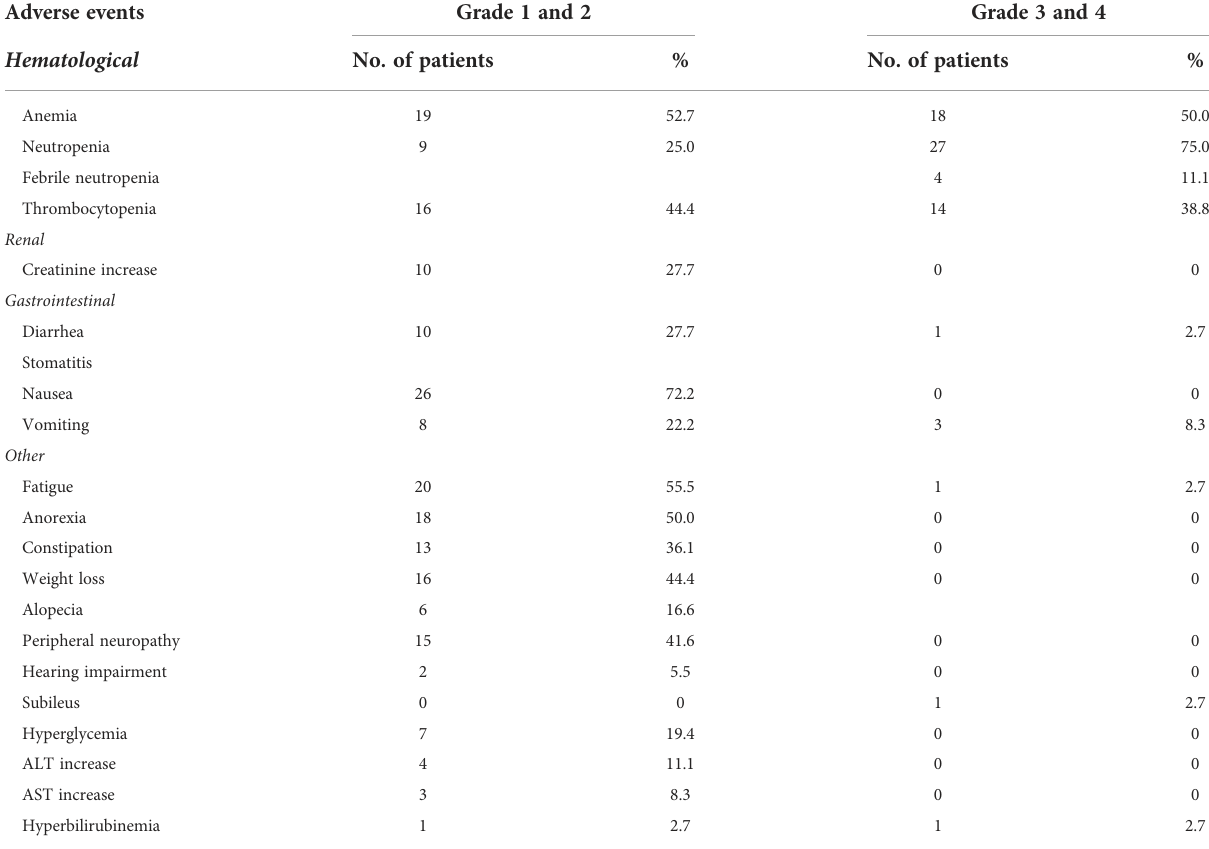
TABLE 2 Most common adverse events, G2 or